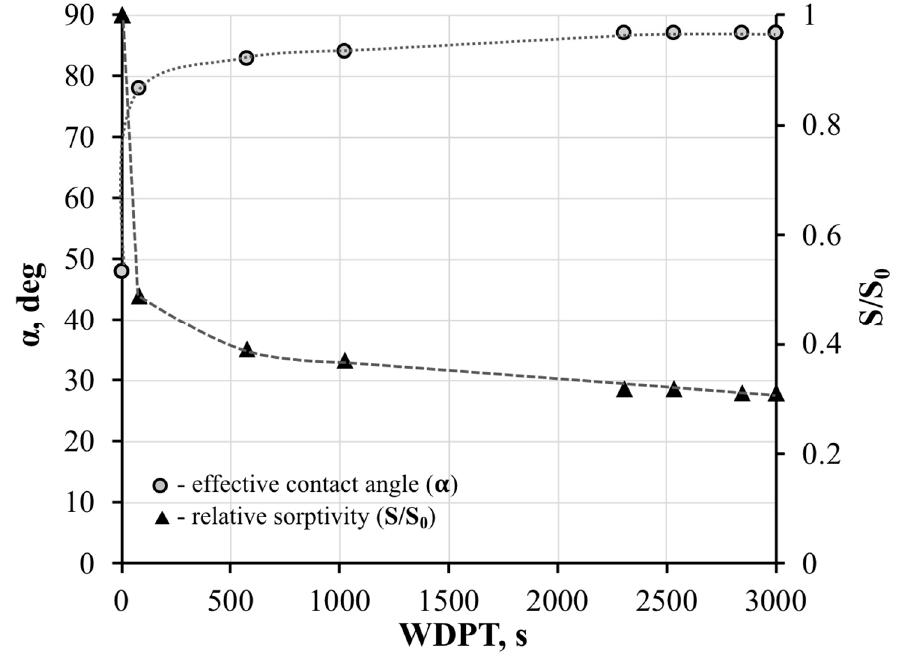
Figure 2. Effective contact angle ( α , degrees) and relative sorptivity (S/S 0 ) as functions of water drop penetration time (WDPT, s).